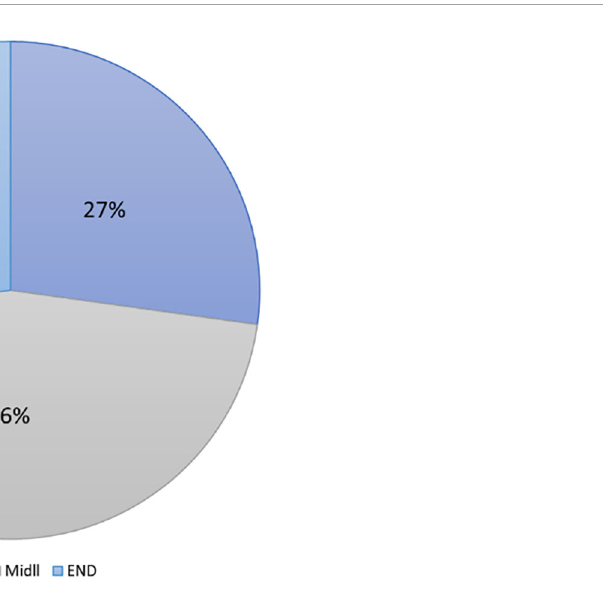
FIGURE 3 Percent of the number of copies per station, 46% of DNA copies obtained by qPCR were in middle stations of trawling.